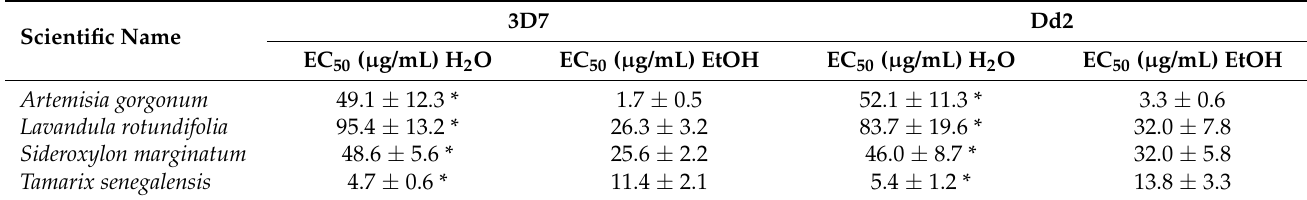
Table 2. EC 50 values of studied plant extracts against P. falciparum